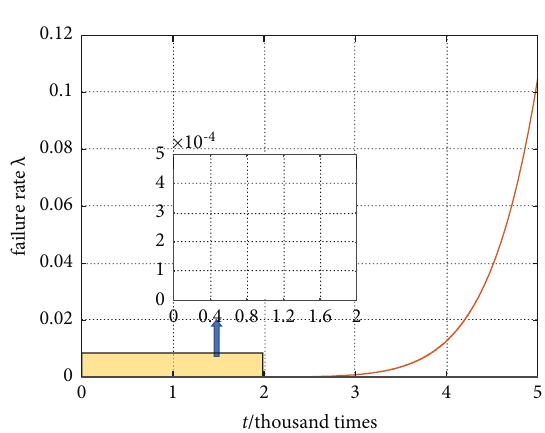
Figure 12: Failure rate function